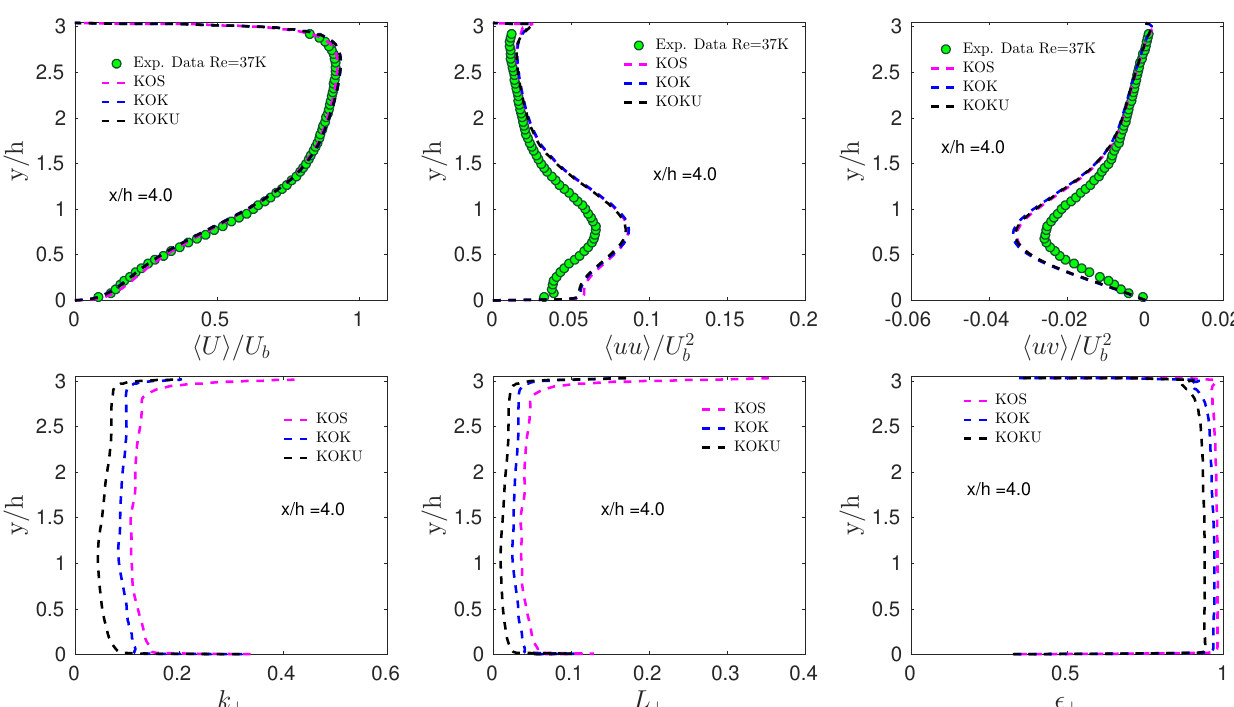
Figure 6. Profiles of flow variables and resolution indicators obtained by periodic hill flow simulations for the Re = 37 K (500 K grid case) at x / h = 4. CES models applied are specified in the plots. The first row shows the mean velocity, streamwise normal, and Reynolds shear stress. The resolution indicators k + , L + , and (cid:101) + are shown in the second row. Reprinted with permission from Ref. [17]. Copyright 2020 AIP Publishing. Figure 7 addresses the core problem: the functioning of the mode communication to accomplish a proper redistribution of modeled and resolved motions. The expectation is simple: a coarser grid and a higher Re need to imply an increased amount of